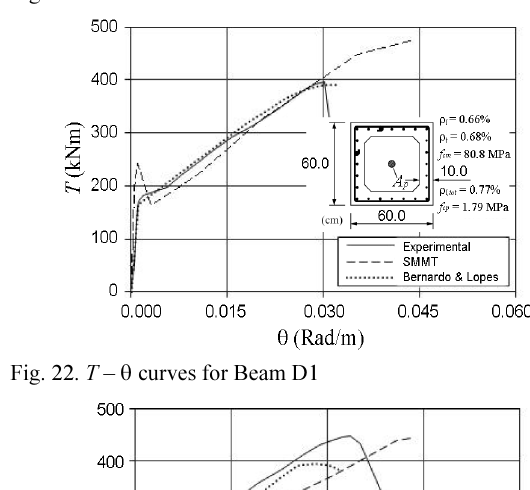
Fig. 21. T – θ curves for Beam P2